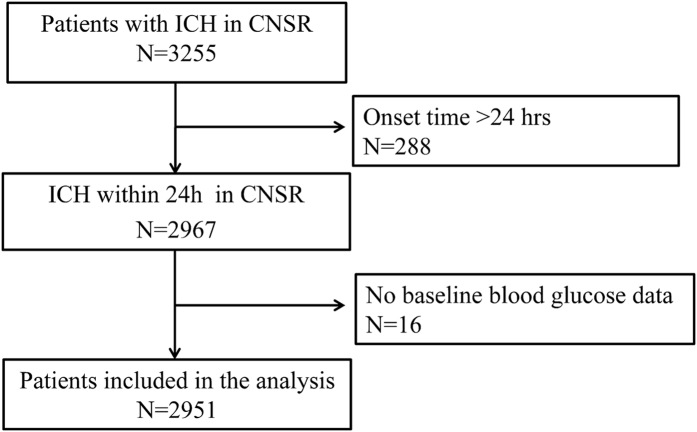
Patient flow diagram.